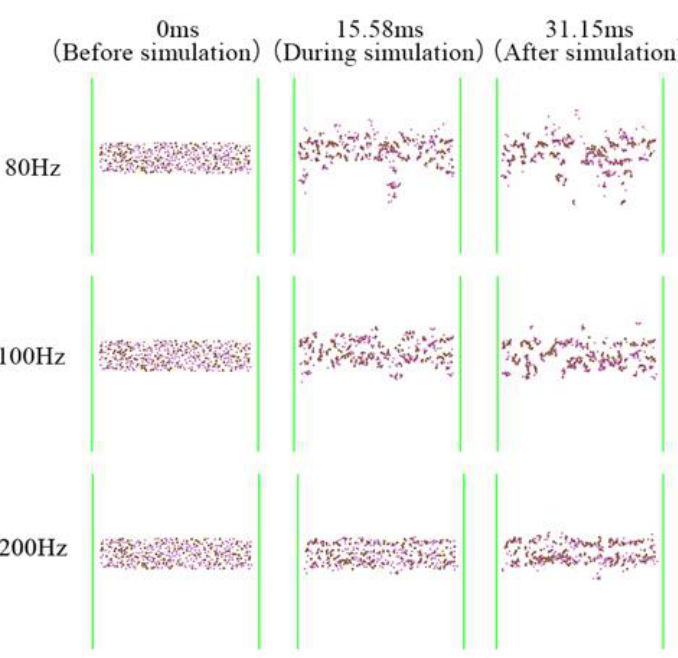
Figure 6. Simulation results of the acoustic agglomeration under the sound waves with SPL = 100 dB for different sound frequencies.